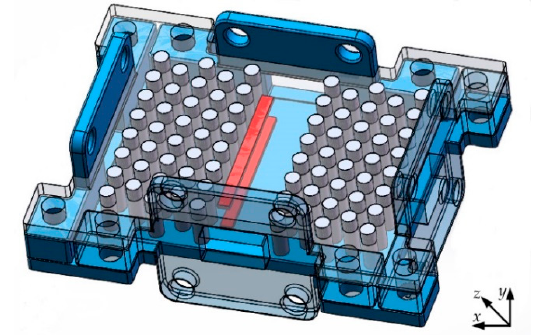
Figure 1. Magneto-optical (MO) isolator based on the photonic crystals waveguide (PCW) and gyromagnetic ferrites.